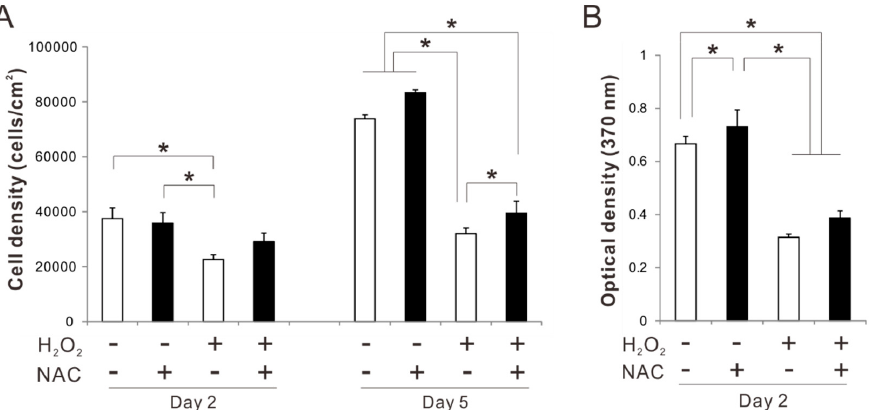
Figure 4. Effects of preconditioning osteoblast-like cells with N -acetyl- L -cysteine (NAC) on proliferation under oxidative stress. Rat femur bone marrow-derived osteoblast-like cells were preincubated with or without 5 mM NAC for 3 h and then cultured in an osteogenic differentiation medium with and without exposure to 50 μ M H 2 O 2 for 2 or 5 days. Attached cell numbers ( A ) and proliferative activity ( B ) in each condition were measured by cell-counting with a hematocytometer and bromodeoxyuridine, 5-bromo-2'-deoxyuridine-incorporation assay, respectively. The data represent the mean ± standard deviation ( n = 3). Asterisks indicate statistically significant differences ( p < 0.05, Tukey’s HSD test).